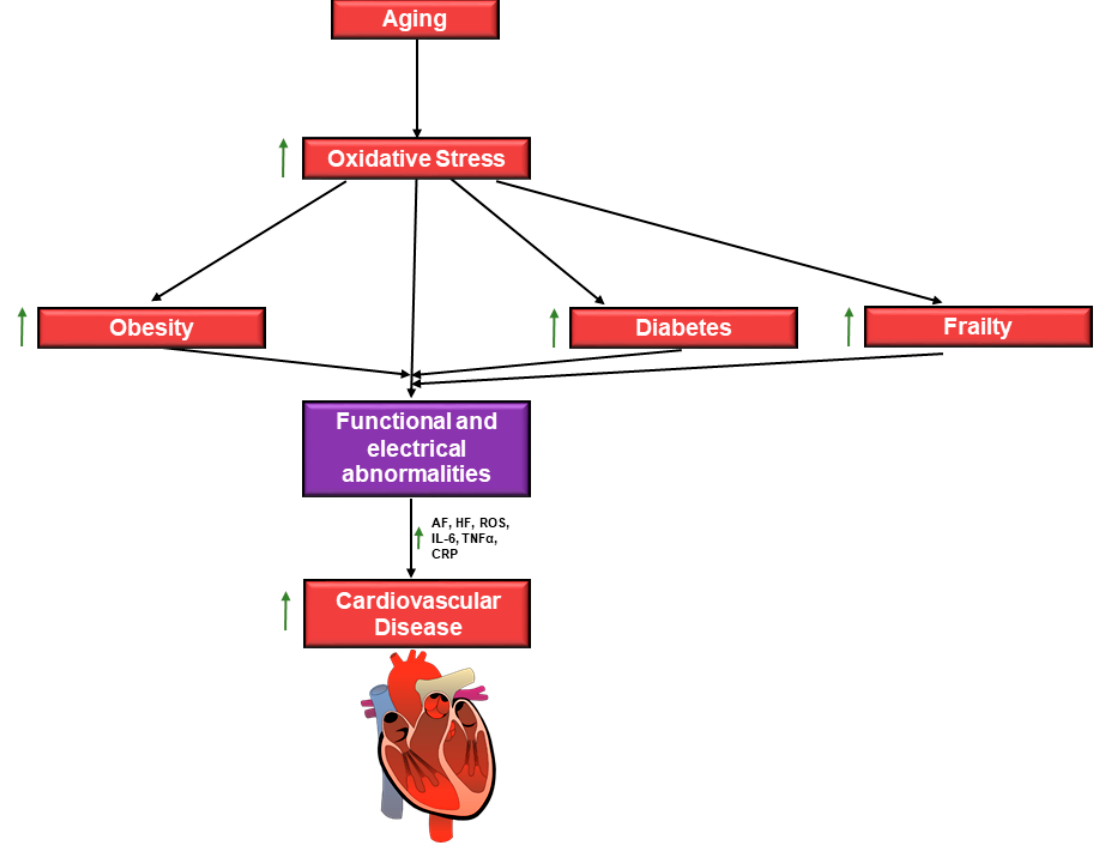
Figure 1. Schematic diagram of age-related risk factors for cardiovascular disease (CVD). Age is associated with increased oxidative stress, which leads to an increased susceptibility for functional and electrical abnormalities which lead to CVD. These abnormalities include atrial fibrillation (AF) and heart failure (HF), which are a result of increased reactive oxygen species (ROS) due to oxidative stress and increase production of inflammatory signal molecules. Age is also associated with an increased risk for frailty, obesity, and diabetes. These conditions are also independent risk factors for CVD. Multiple risk factors result in a high incidence of CVD in aging adults. In this figure indicates upregulation. Tumor necrosis factor- α (TNF α ), C-reactive protein (CRP), and interleukin-6 (IL-6).